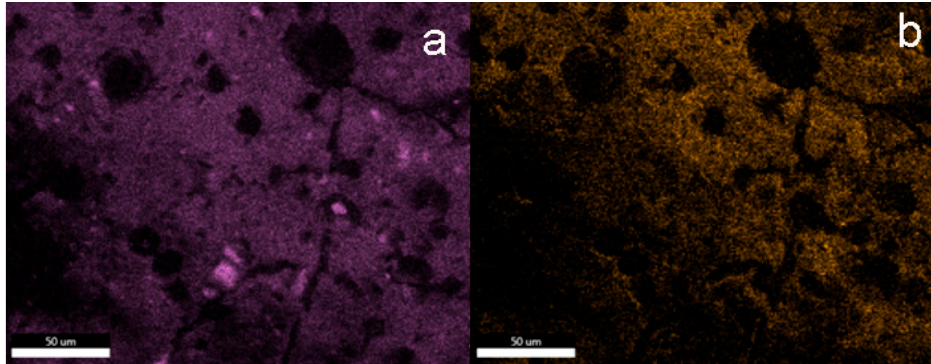
Figure 5. EDS mapping of the elements on the F5_5 surface; element map of Si ( a ) and F ( b ).